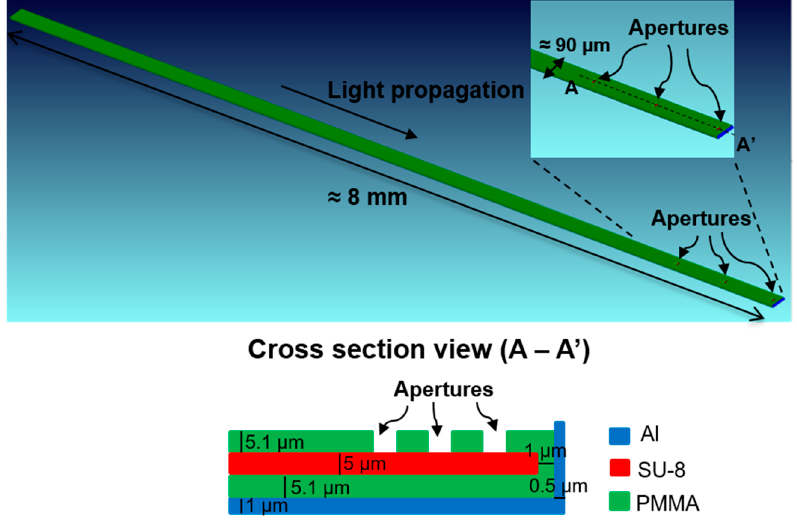
Figure 2. Geometry of the simulated